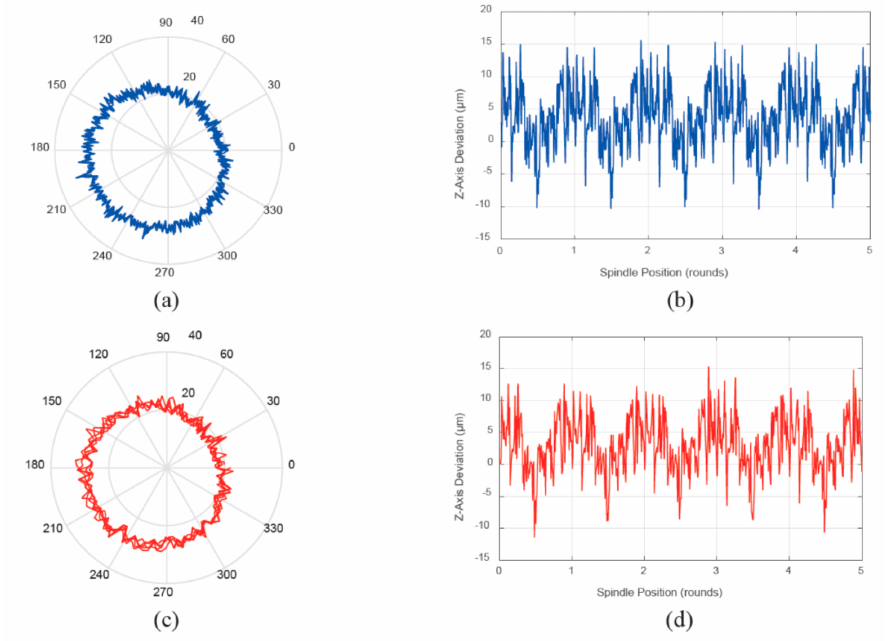
Figure 42. Total spindle error motion: ( a ) xy-plane at 100 rev/min, ( b ) z -axis at 100 rev/min, ( c ) xy-plane at 500 rev/min, and ( d ) z -axis at 500 rev/min